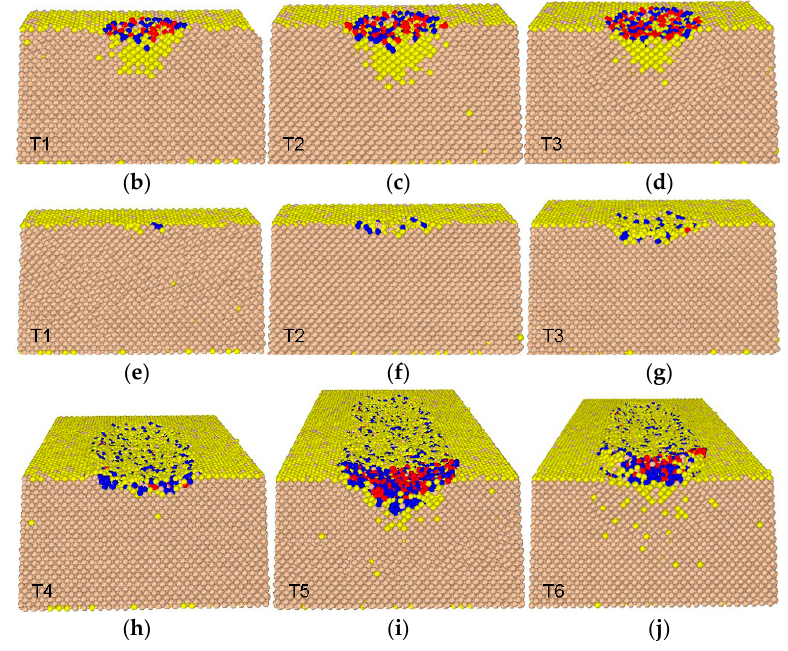
Figure 7. ( a ), whole cross-section view of phase distribution induced by rolling of particle with axial ratio 0.40; ( b – d ), cross-section view of initial loading region labelled by T1–T3 before the top substrate moving and ( e – g ) after the top substrate moving; ( h – j ), cross-section view of particle sliding region (T4) and particle occupying region (T5 and T6). Atomic color is similar to that coding in Figure 2. For the particle rolling process, the specimen deformation showed a clear difference at different movement stages and exhibited a periodical feature, for instance, the depth of deformed region and the number of deformed atoms for the ellipsoidal particle at upright position (see Figure 6a,i) were larger than that at lying posture (Figure 6a,h). However, for the particle sliding process, the deformation of specimens was nearly homogeneous in the whole scratched region in Figure 7a,h. The particle with sliding movement pattern could scratch the substrate surface, and then lead to more atom accumulation ahead of particle, but less deformation within substrate, when compared with rolling movement. Consequently, we can find in Figures 6j and 7i,j that the phase-transformation atoms induced by rolling particle were more than that by sliding particle. Figure 6a,h–j show after three-body abrasion, only a part of Bct5 atoms and many Si-II atoms transformed into Si-I or Si-III/Si- XII atoms, whilst the other Si-II and Bct5 atoms still remained. Whereas, Figure 7a,h–j show that the transformation from Si-II and Bct5 phase to Si-I phase increased, whilst the remained Si-II and Bct5 atoms were restricted only within several layers in the scratched region, and almost all of Si-III/Si-XII atoms generating from either Si-I or Si-II and Bct5 atoms disappeared because of the pressure releasing. The similar phase transformation phenomena were also observed in two-body abrasion [24,25].